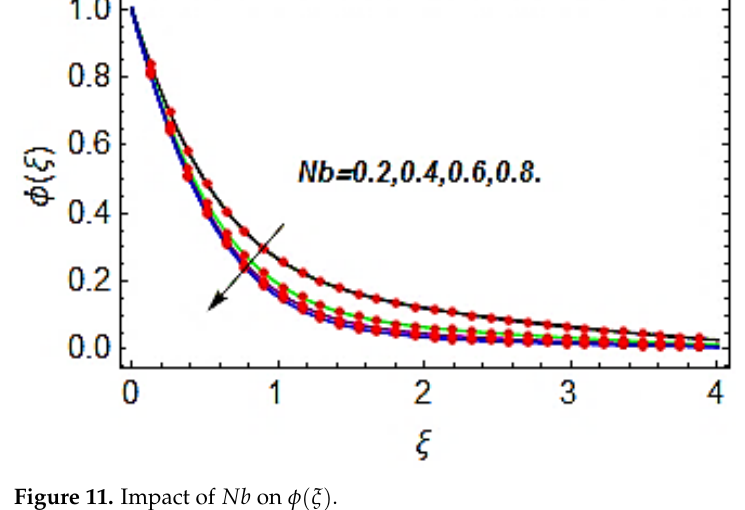
Figure 11. Impact of Nb on φ ( ξ ) .